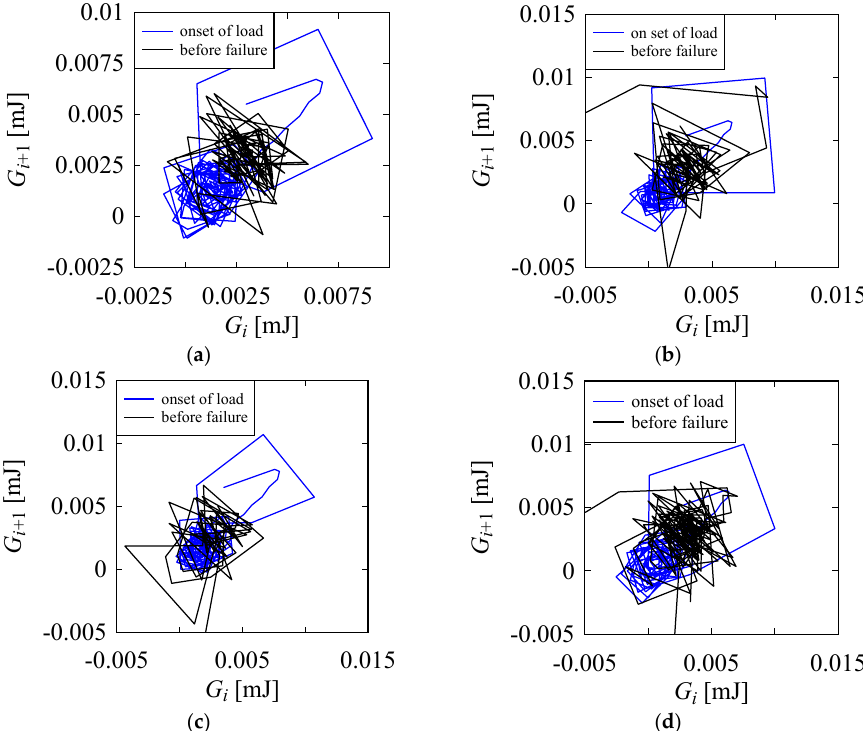
Figure 7. Return maps of energy difference at the onset of load and before failure. ( a ) Specimen 1; ( b ) Specimen 2; ( c ) Specimen 3; ( d ) Specimen 4.